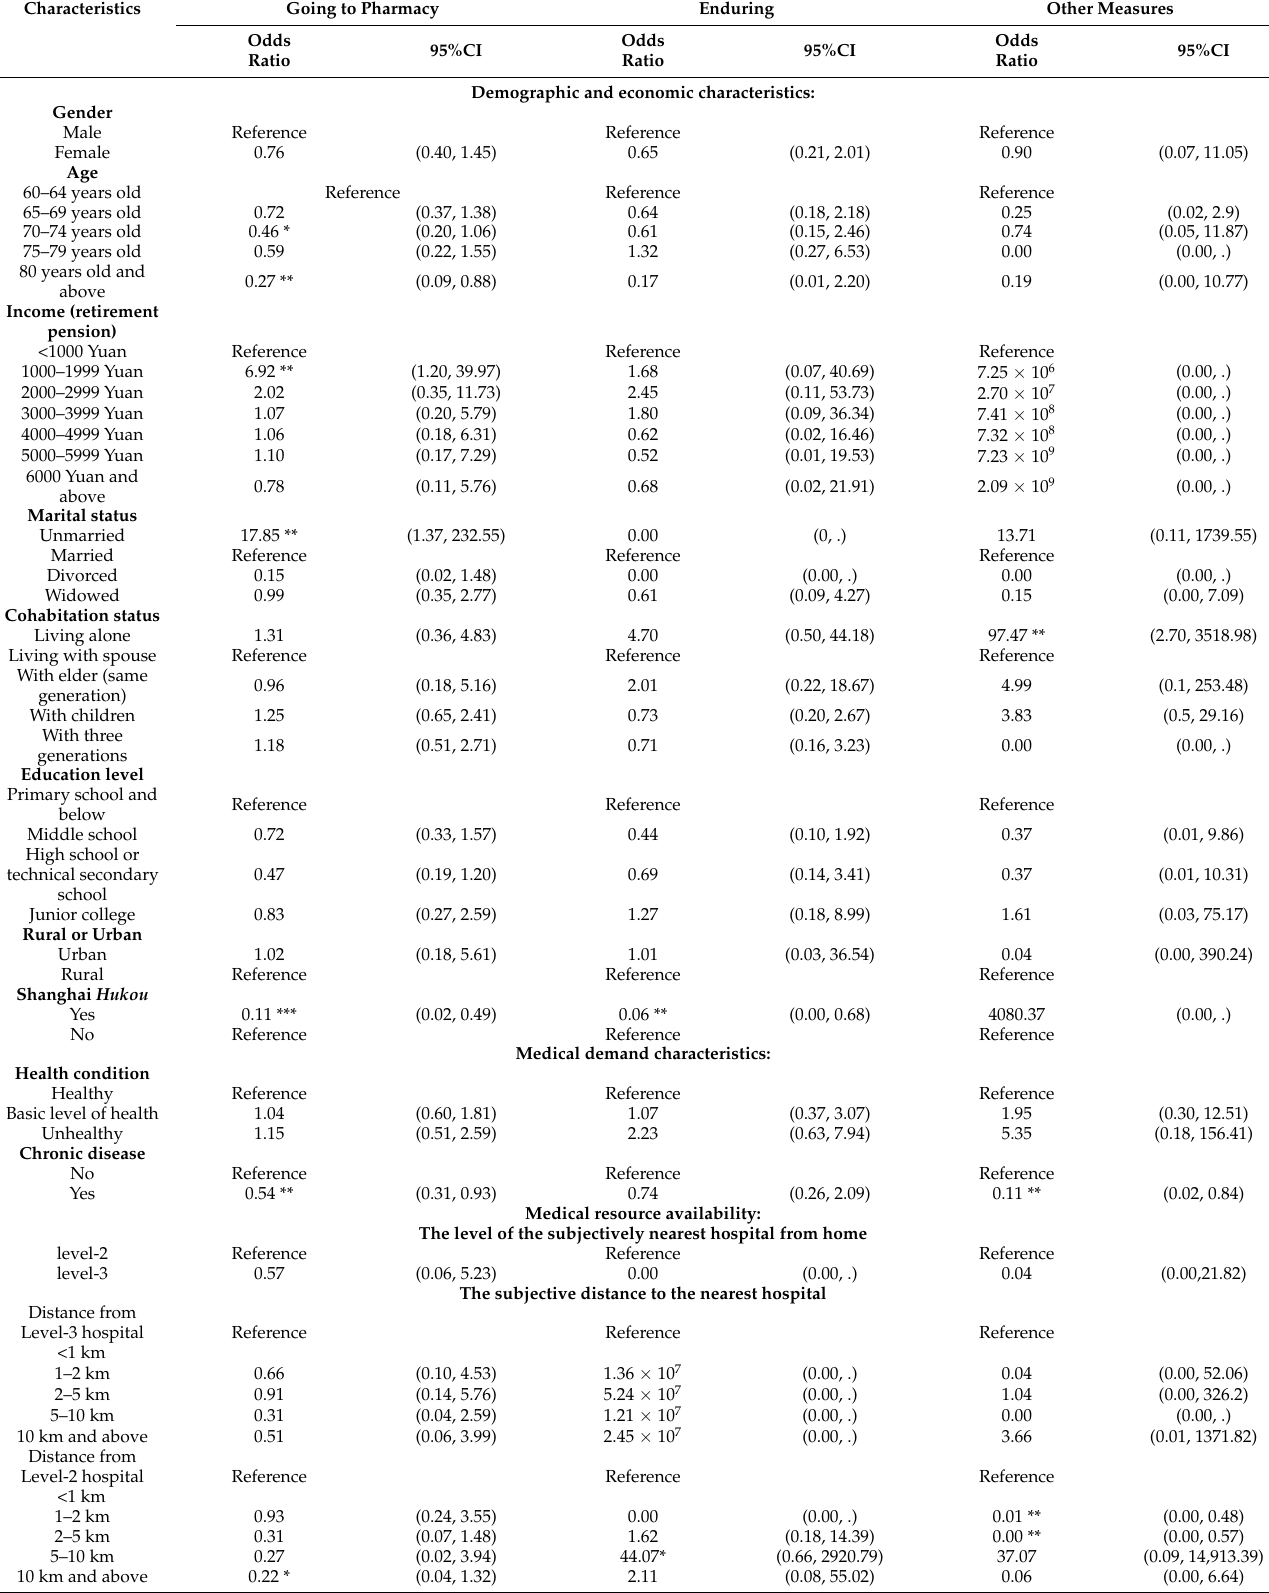
Table 2. Parameter estimation for the elderly population in the condition of physical discomfort (control group = going to